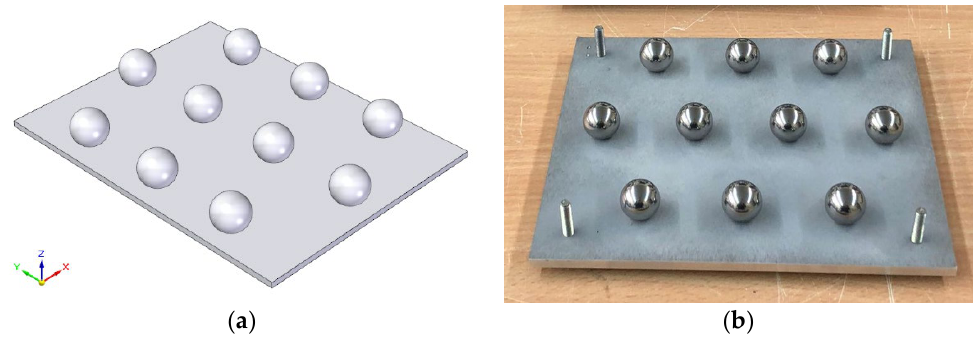
Figure 1. ( a ) Basic design of the spheres plate. ( b ) Plate with Ø18 mm precision spheres before acid etching.